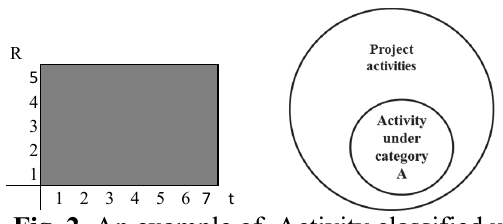
Fig. 2. An example of Activity classified under category